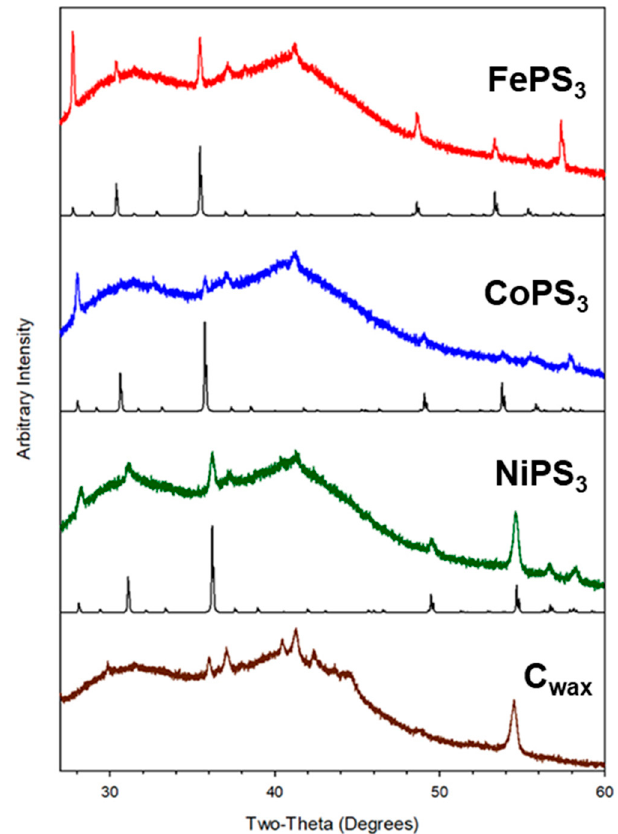
Figure 8. XRD data for MPS 3 embedded on carbon wax tips after 18 h CA HER experiments. The black standard reference patterns are shown under each data set (FePS 3 -PDF #04-005-1516, CoPS 3 -PDF #01-078-0498, NiPS 3 -PDF #01-078-0499).